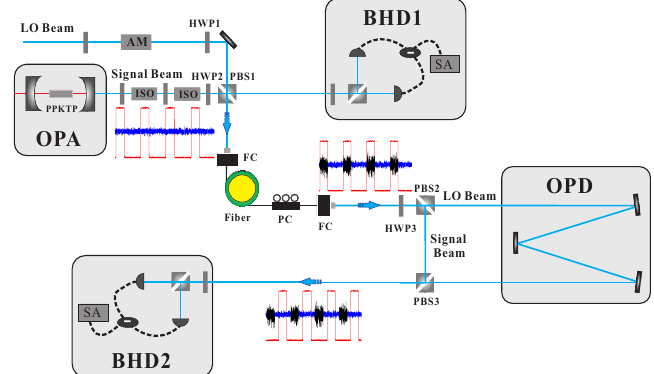
PBS3PBS2 Figure 2. Schematic diagram of the experimental device. OPA: optical parametric amplifier. PPKTP: periodically poled KTiOPO 4 . AM: amplitude modulator. HWP1-3: half wavelength plate.